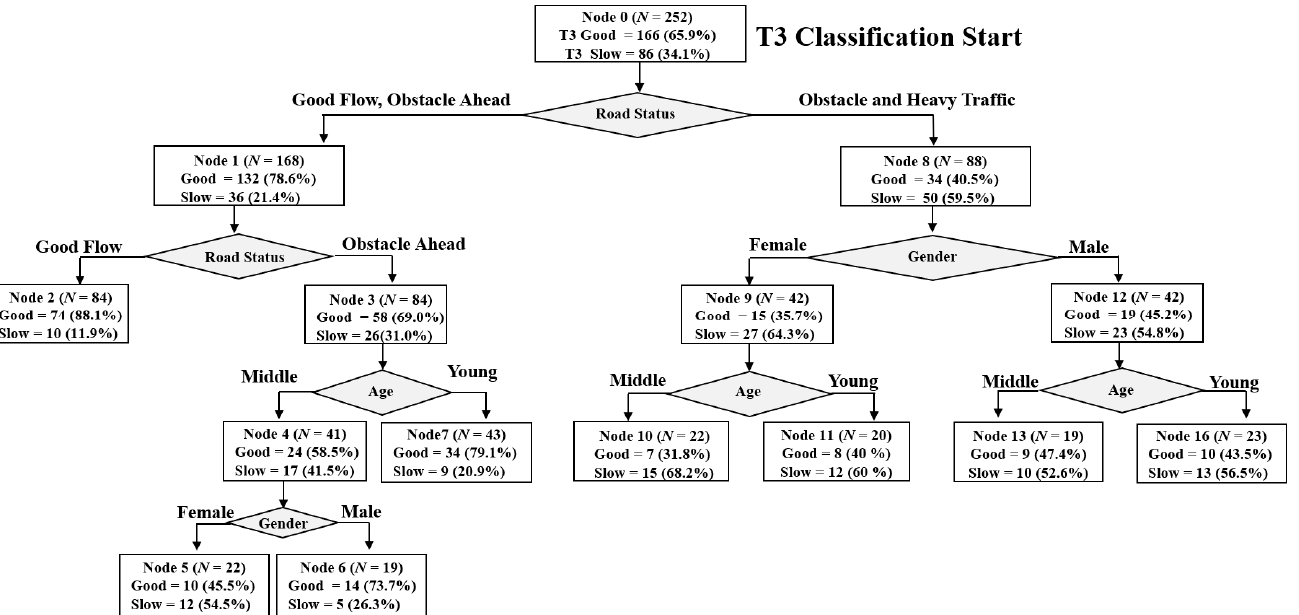
Figure 6. CART decision tree for T3.